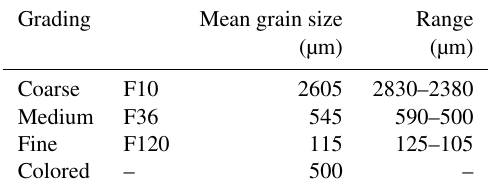
Two different materials were used for the experiments: Table 1. Characteristics of the material